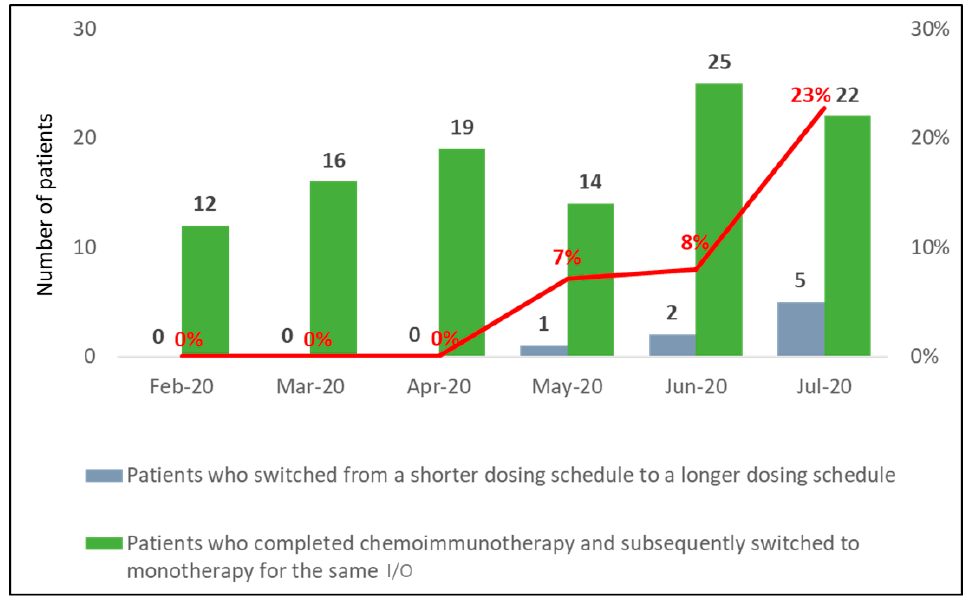
Figure 4. Overall switching rate for the immunotherapies of interest among patients with stage IV NSCLC; I/O, immuno-oncology